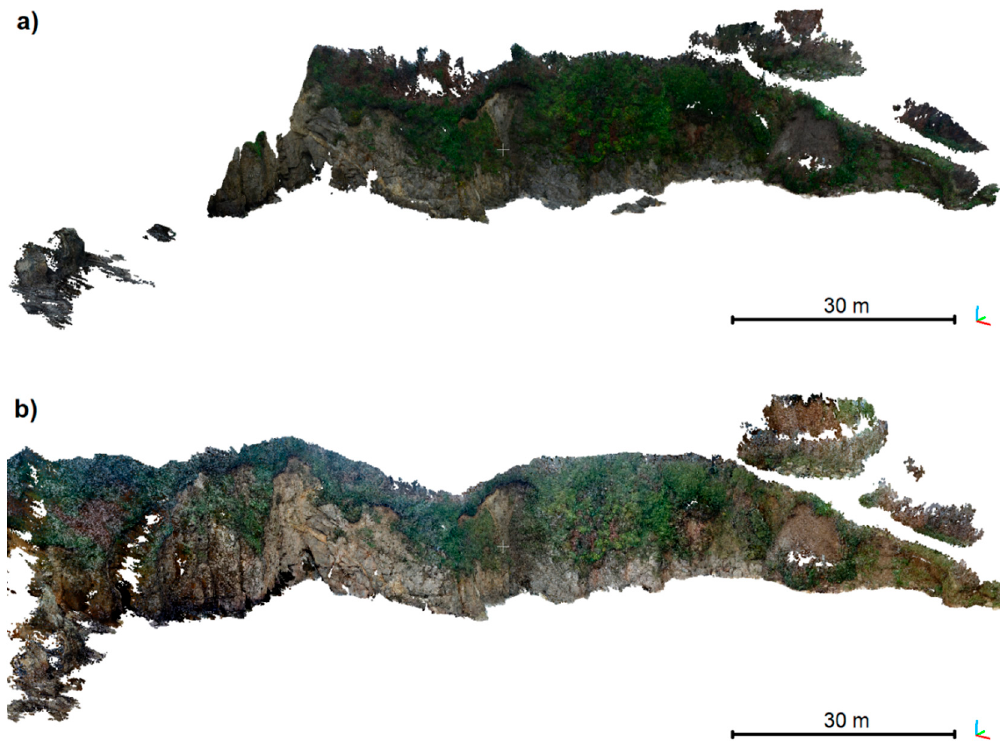
Figure 4. Colored dense point clouds obtained using the photographs collected by the Nikon D800 Reflex camera ( a ) and the Huawei Smartphone camera ( b ).